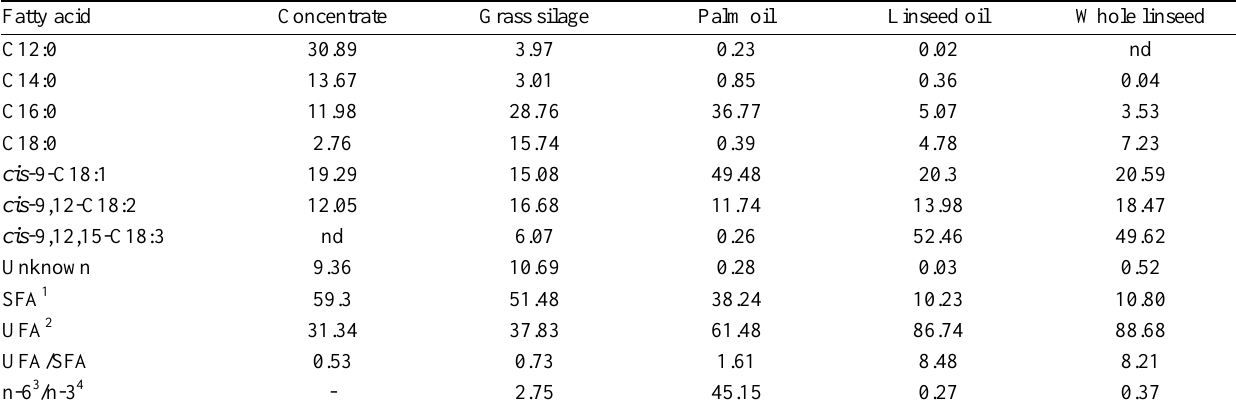
Table 2. Fatty acid composition of feeds (% of total fatty acids) used in the experiment Fatty acid Concentrate Grass silage Palm